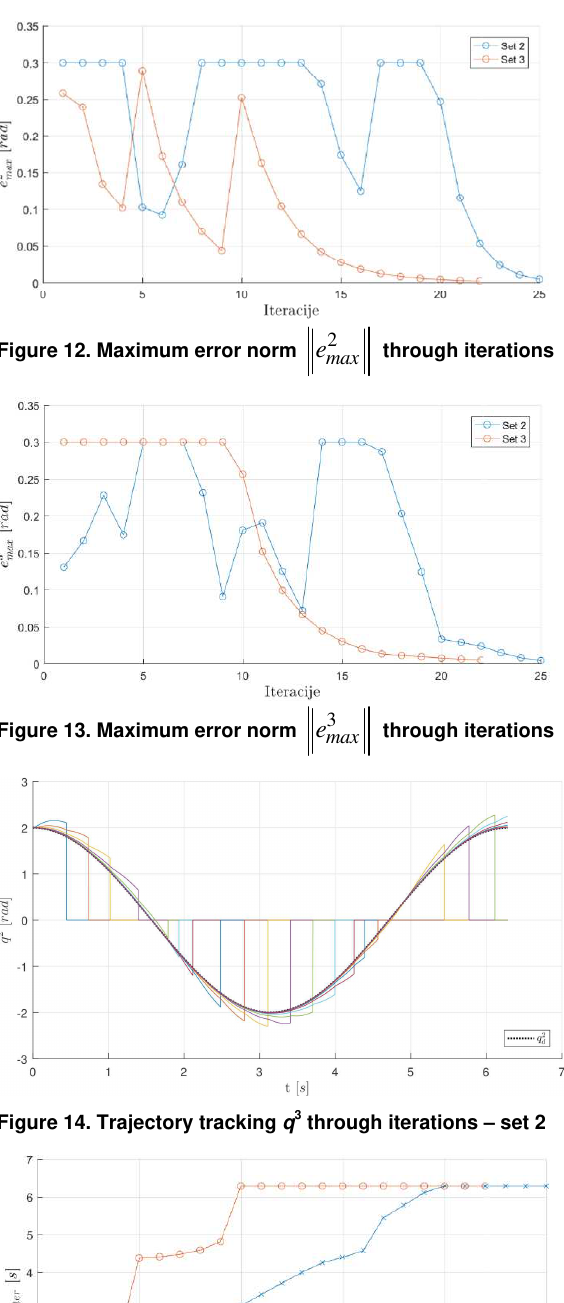
Figure 17. Maximum error norm